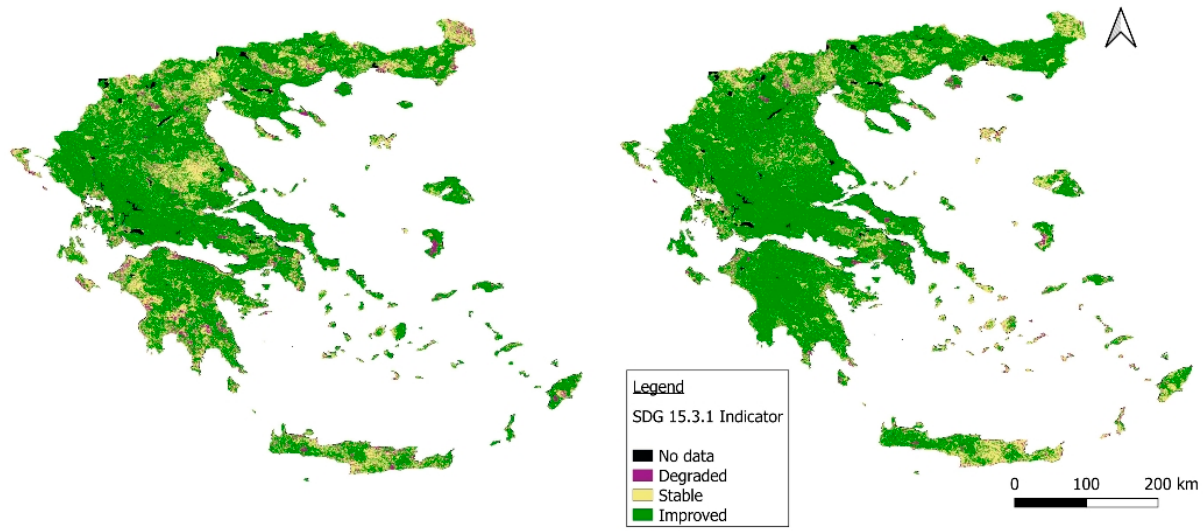
Figure 2. Spatial distribution of SDG 15.3.1 indicator in Greece during the baseline period ( left ) and the reporting period ( right ).